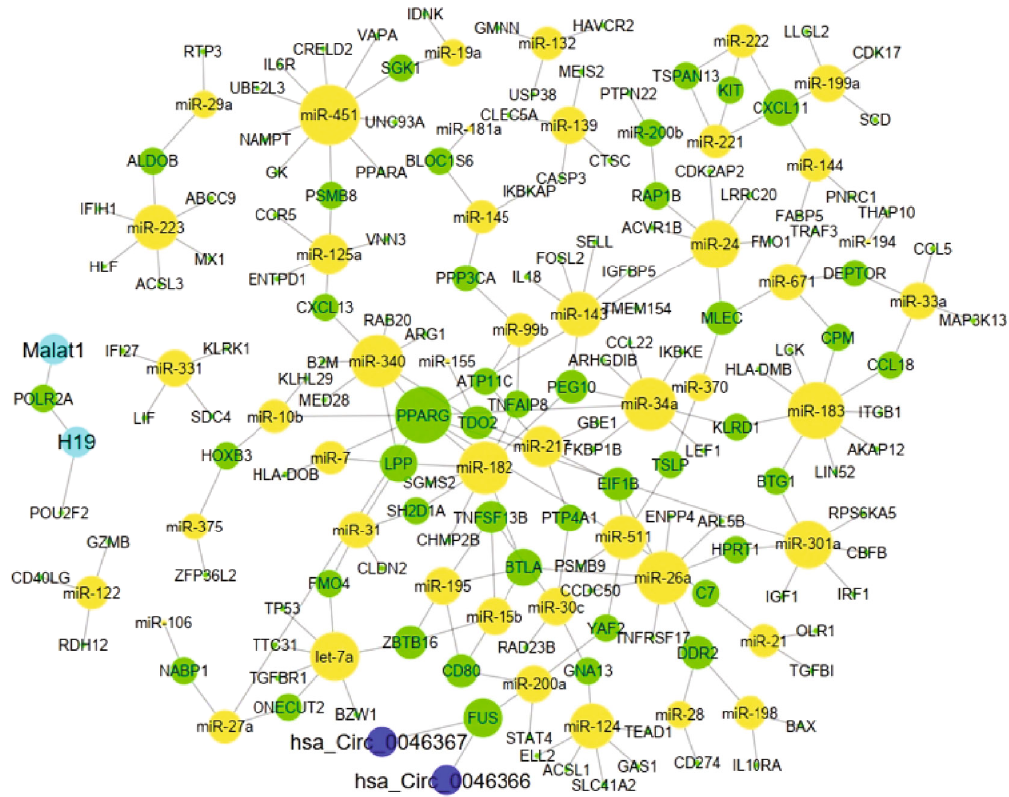
Figure 6: Interaction network construction and analysis of causal ncRNAs-fatty liver mRNAs. Hub genes and hub ncRNAs based on degree centrality parameter are showed as bigger nodes. MiRNAs, mRNAs, circular RNAs, and lncRNAs are depicted as yellow, green, blue, and turquoise nodes,